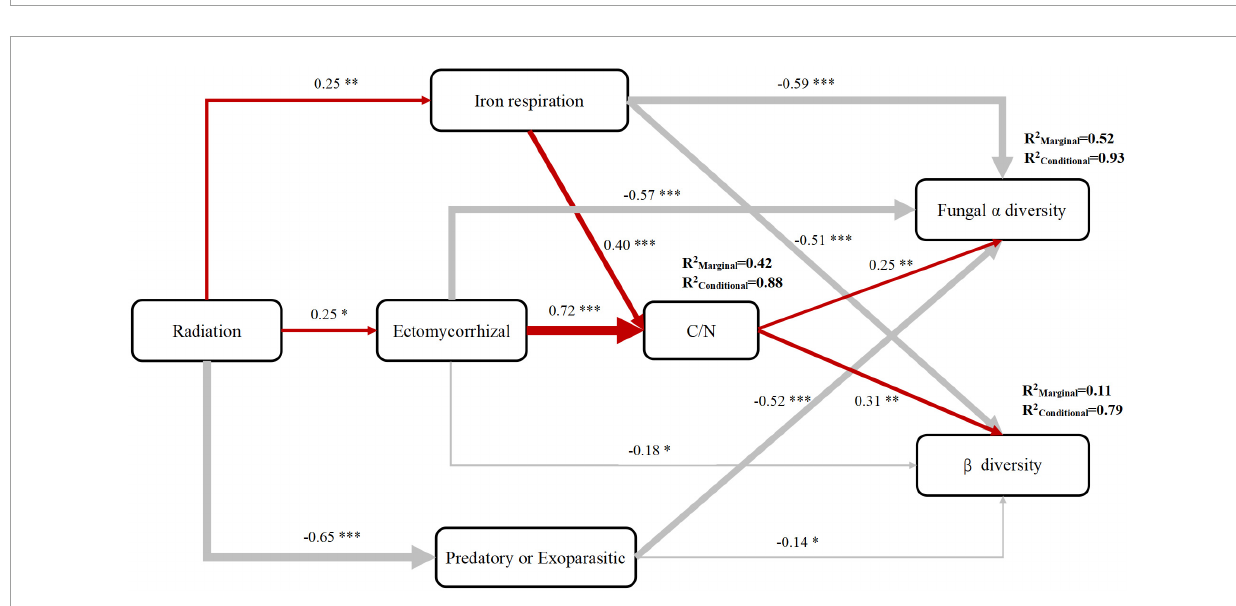
FIGURE10 Structural equation model explaining the effect of gamma radiation on the soil microbial community (Fisher’s C = 27.23, P = 0.257, DF = 20, AIC = 73.230). Red and gray arrows indicate positive and negative relationships, respectively. Numbers next to the arrows indicate the normalized path coefficients. *Represents its significance: ∗ < 0.05; ∗∗ < 0.01; ∗∗∗ < 0.001. The SEM explained 56% of C/N ratio, 52% of fungi α diversity, and 41% of microorganisms β